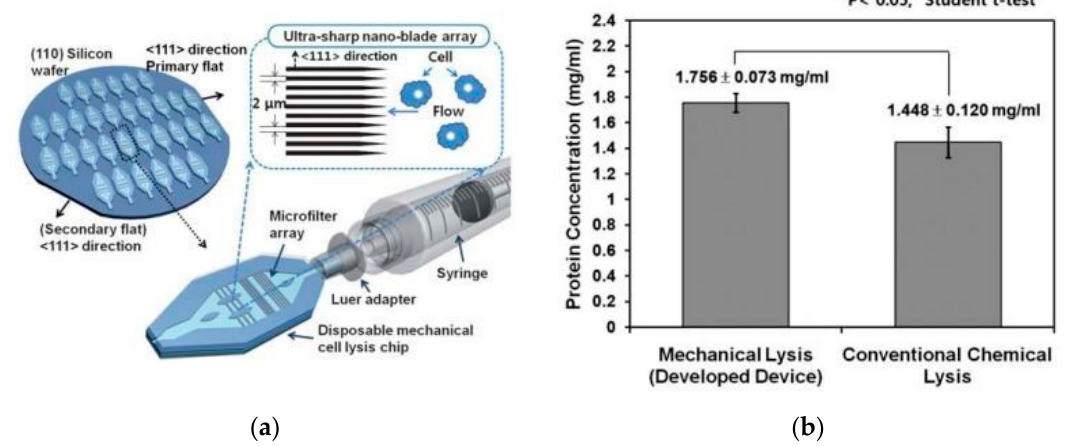
Figure 11. ( a ) Schematics of the chip for mechanical cell lysis chip with ultra-sharp nano-blade arrays utilized [40]. ( b ) Comparison of protein concentration between the developed mechanical cell lysis method and the conventional chemical lysis method. Adapted with permission from [40]. Copyright 2010 Royal Society of Chemistry.